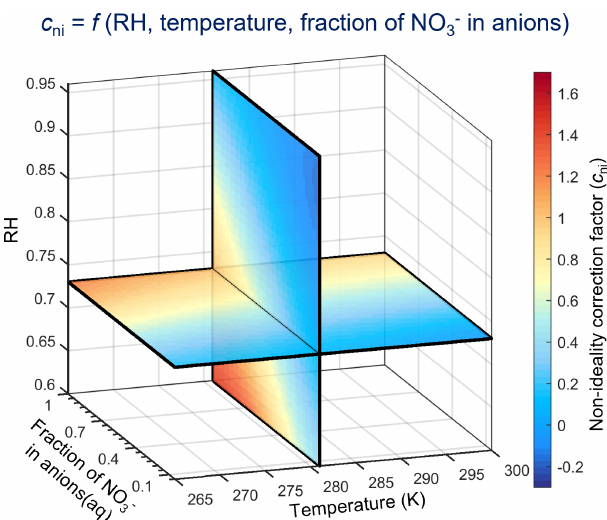
Figure 3. Example slices of the c ni parameterization based on “AIM_molality” estimations as given in Data S1 in the